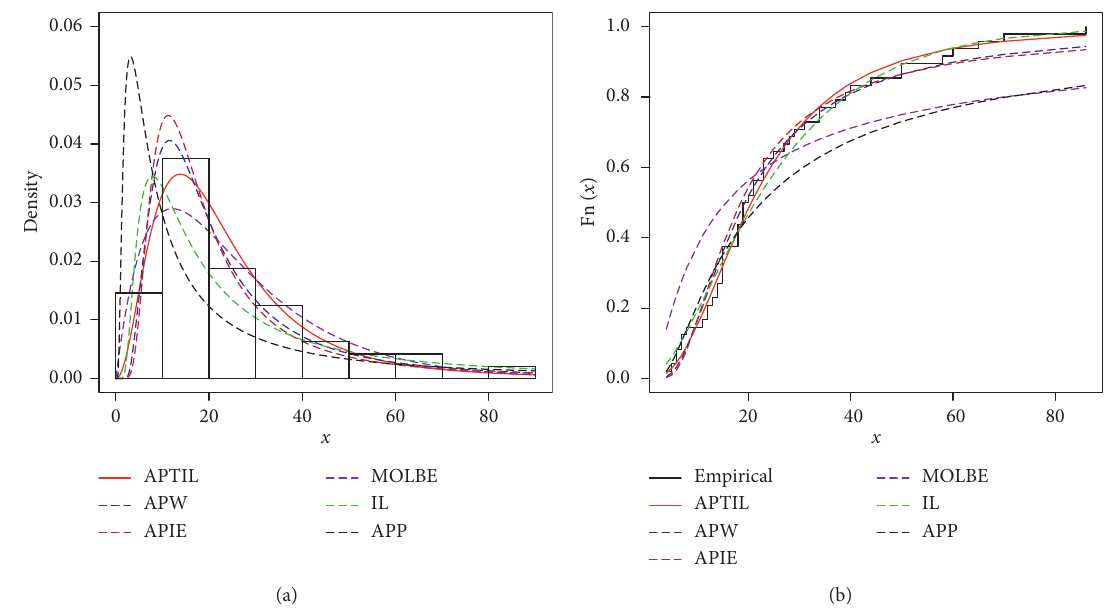
Figure 6: Estimated pdf and cdf of APTIL model and other competing models for second